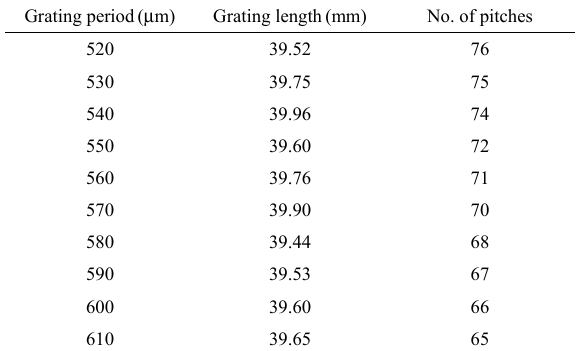
Fig. 1 3D printed LPFG device: (a) designed in Solidworks and (b) observed by SEM. Table 1 Specification of 3D printed LPFG device with different grating